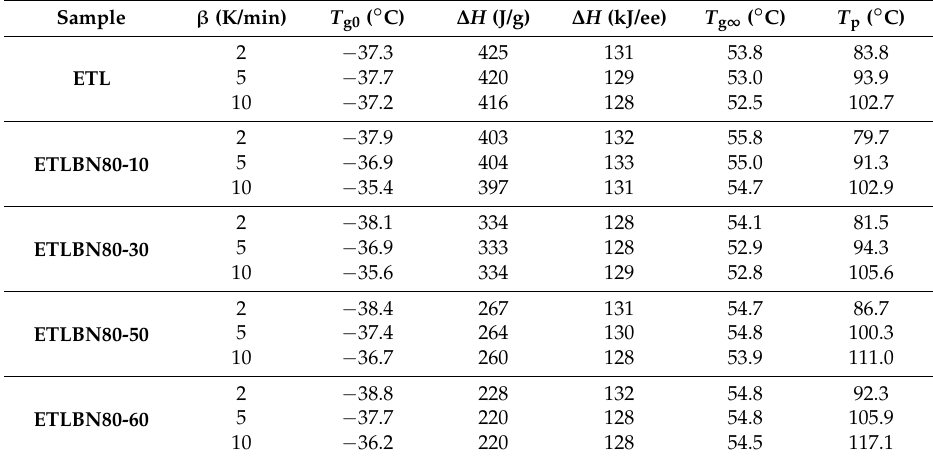
Table 2. Results for ETLBN80 system from non-isothermal DSC cure experiments at different heating rates, β : T g0 , Δ H , T g ∞ , T p .